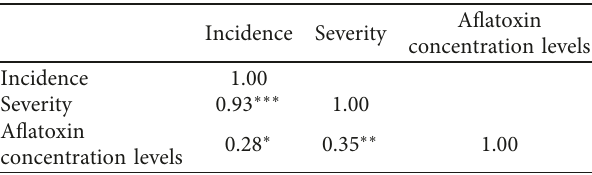
Table 4: Spearman’s rank matrix correlation performed on in- cidence, severity, and aflatoxin concentration levels